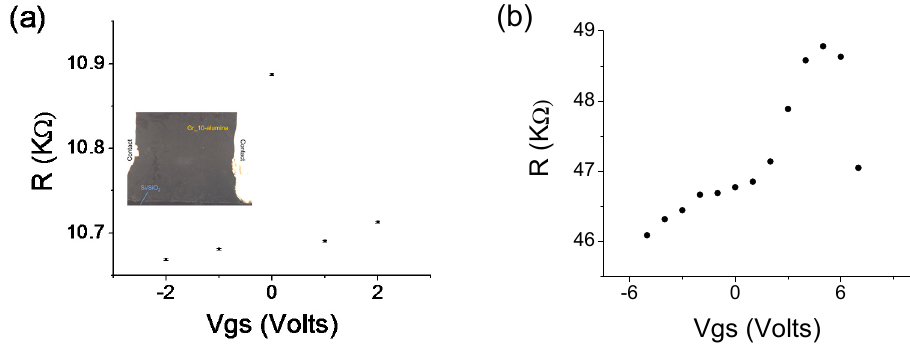
Figure 9. Electrical data for ( a ) 10-nm alumina on graphene and ( b ) 5-nm alumina on graphene. Shown is film resistance as a function of gate voltage. Both films were transferred onto 50-nm thick SiO2 on a Si wafer. Both curves were obtained in up and down directions.